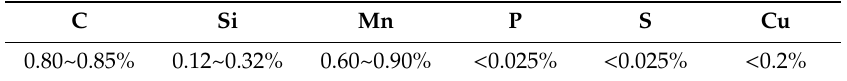
Table 1. Chemical composition of S82B.